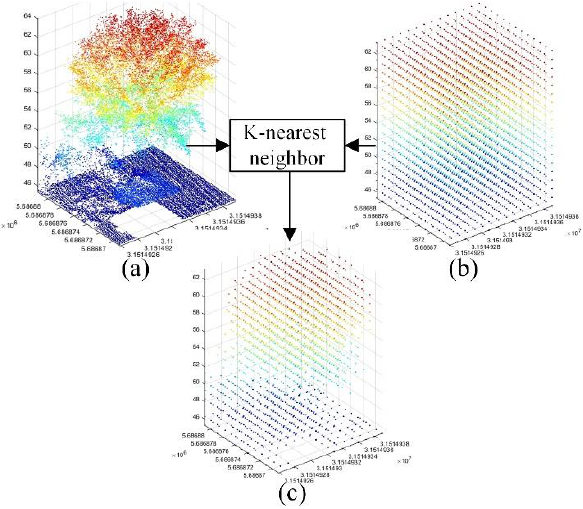
Figure 3 . Mesh method. a) Point cloud, b) Possible grid points generation, c) final grid points